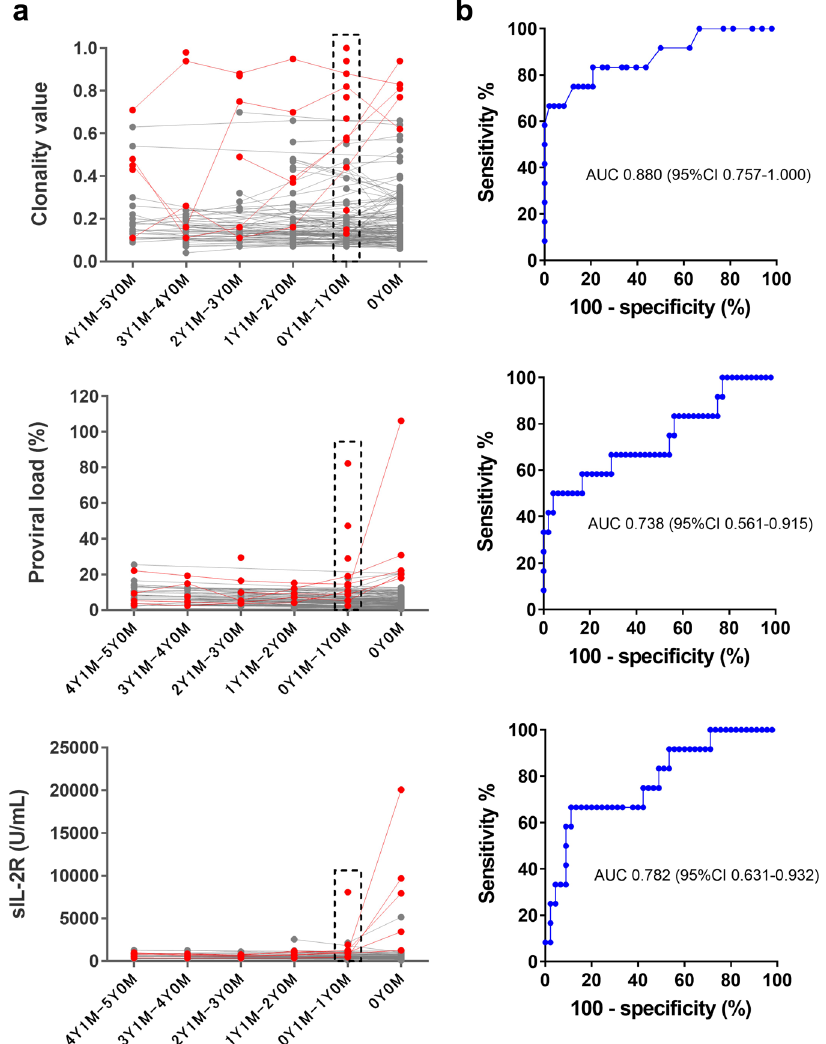
Fig. 4 Longitudinal analysis of progressors to ATL and non-progressors with clonality value (Cv), HTLV-1 proviral load (PVL), and soluble IL-2 receptor (sIL-2R). a Cv (top), PVL (center), and sIL-2R (bottom) of 15 progressors (red) and 130 non-progressors (black). The time point of ATL onset or last observation visit was set to 0 year 0 month (0Y0M) for progressors or non-progressors, respectively. If multiple data existed in each period of one year, the arithmetic means were displayed. Of 15 progressors, 10 had only data at one-time point before the onset. Data used for the ROC analysis shown in b is indicated by dashed rectangles. b ROC analysis using available data from progressors ( n = 12) and non-progressors ( n = 48) in a time point between one month and one year (0Y1M – 1Y0M) before either ATL onset or last observation visit (progressors, median 7.0 months ago; non-progressor, median 6.2 months ago). AUC area under the curve, CI con fi dence interval. Table. 2 Risk assessment of adult T-cell leukemia/lymphoma (ATL) development. Cv PVL sIL-2R Cv PVL sIL-2R 0.50 13.5 1260 Cut-off values a for differentiation between low- 0.24 5.0 479 Cut-off values a for differentiation between middle- and high-risk groups and middle-risk groups Sensitivity